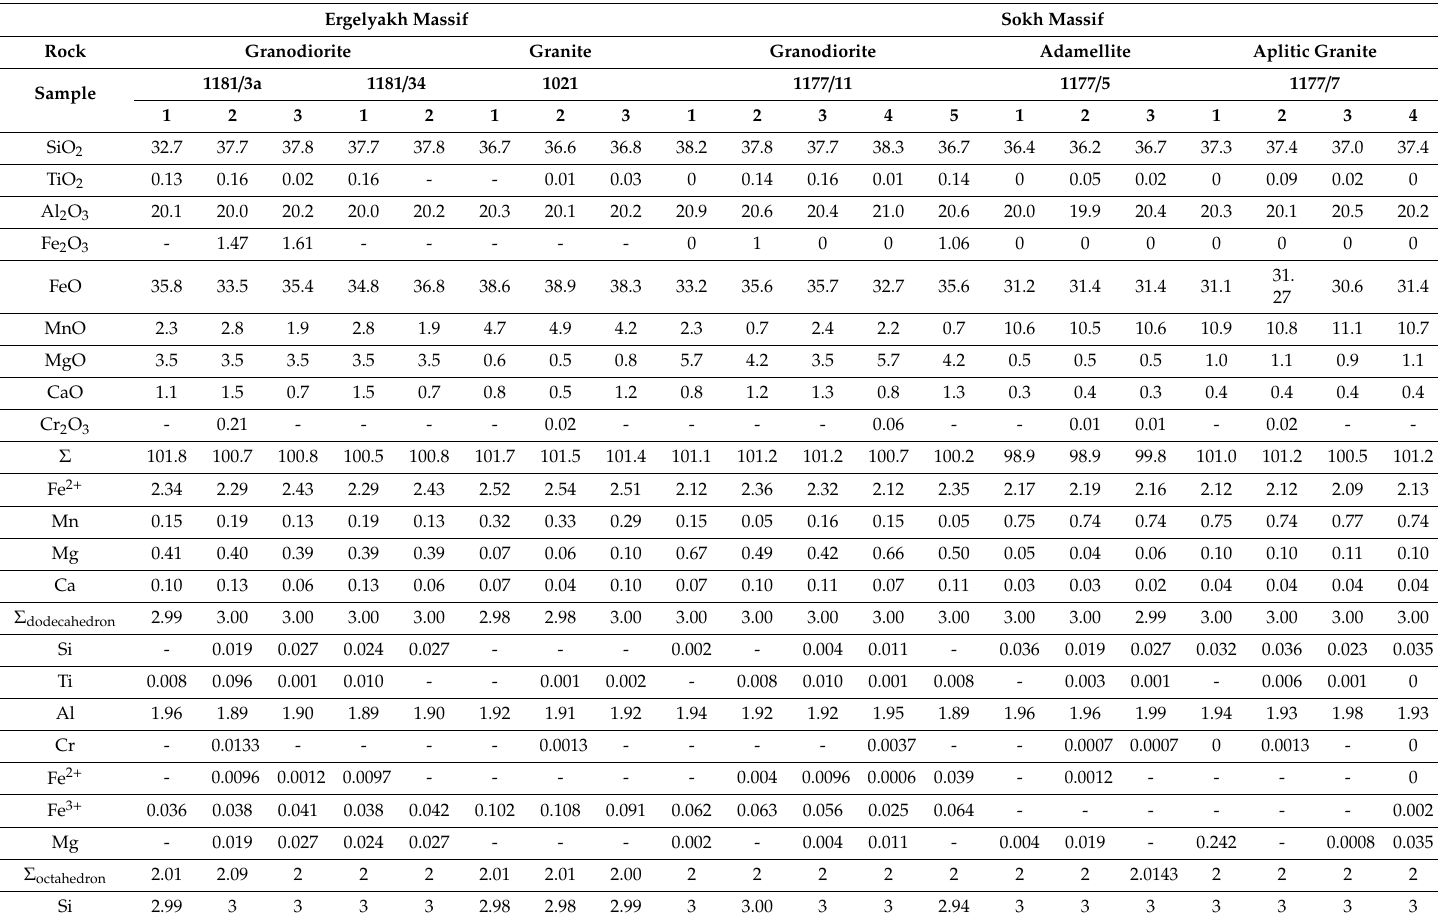
Table 4. Chemical analysis of garnets from Ergelyakh and Sokh